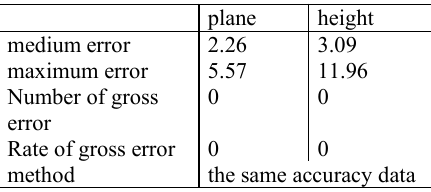
Table 8. Statistical results of field